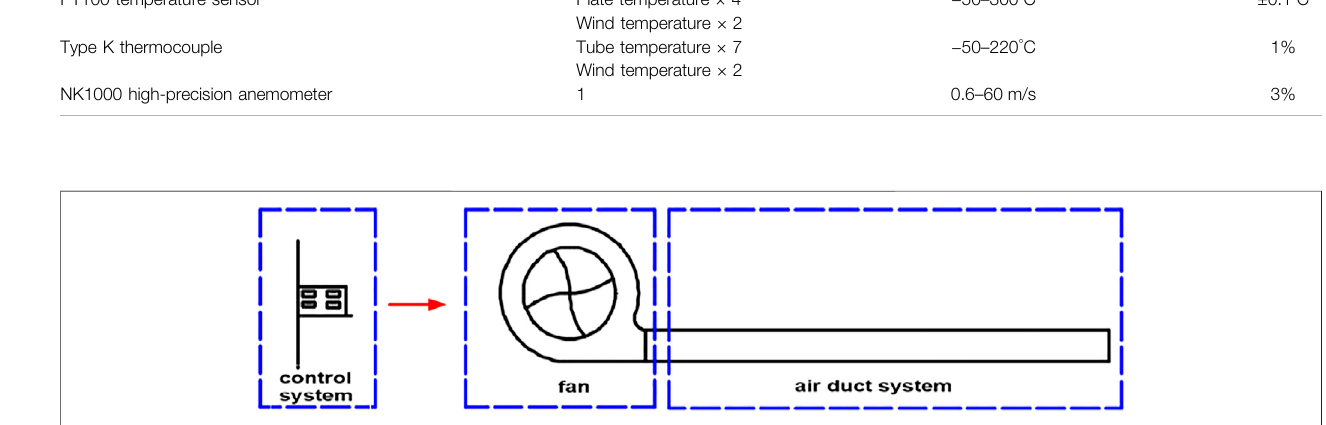
FIGURE 4 | Experimental devices.